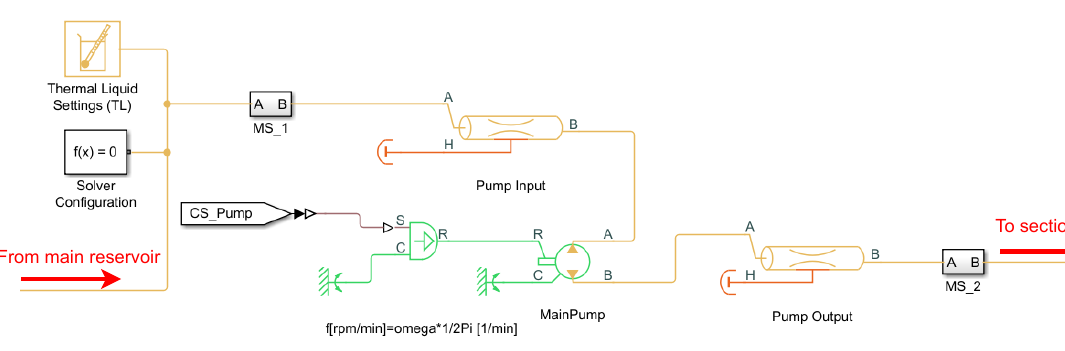
Figure 11. The main pump simulation.